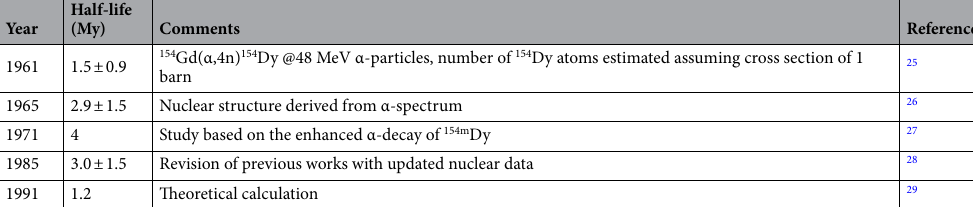
Table 1. Half-life values for 154 Dy available from literature.